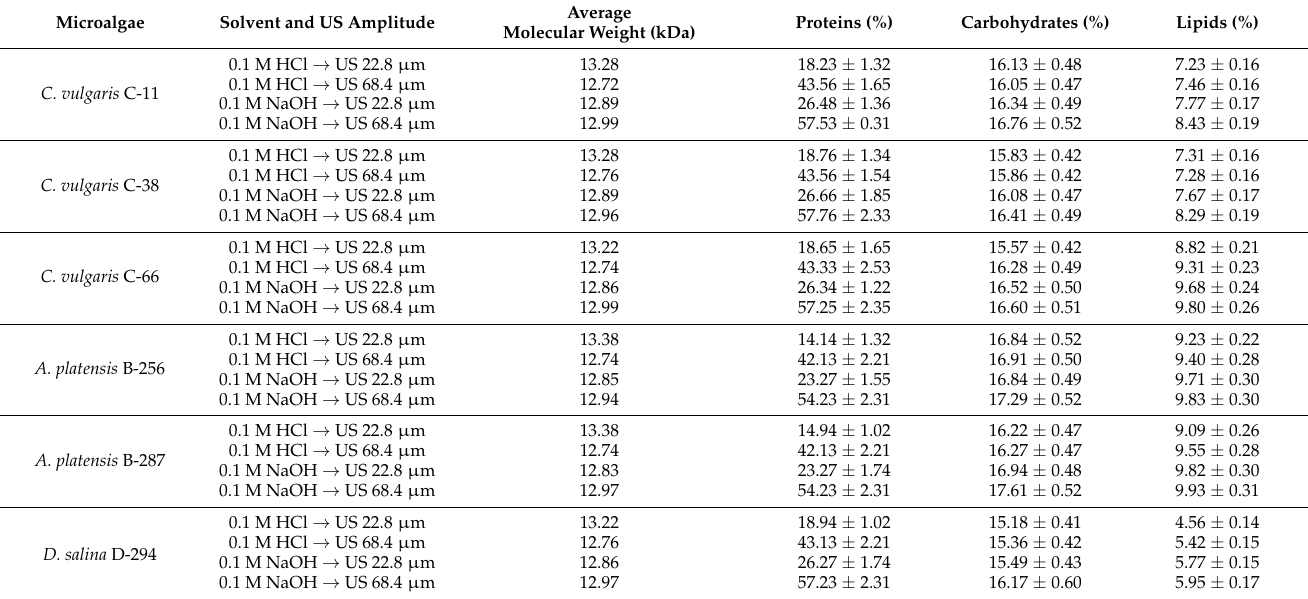
Table 5. The effect of ultrasound (US) on extraction of proteins, carbohydrates, and